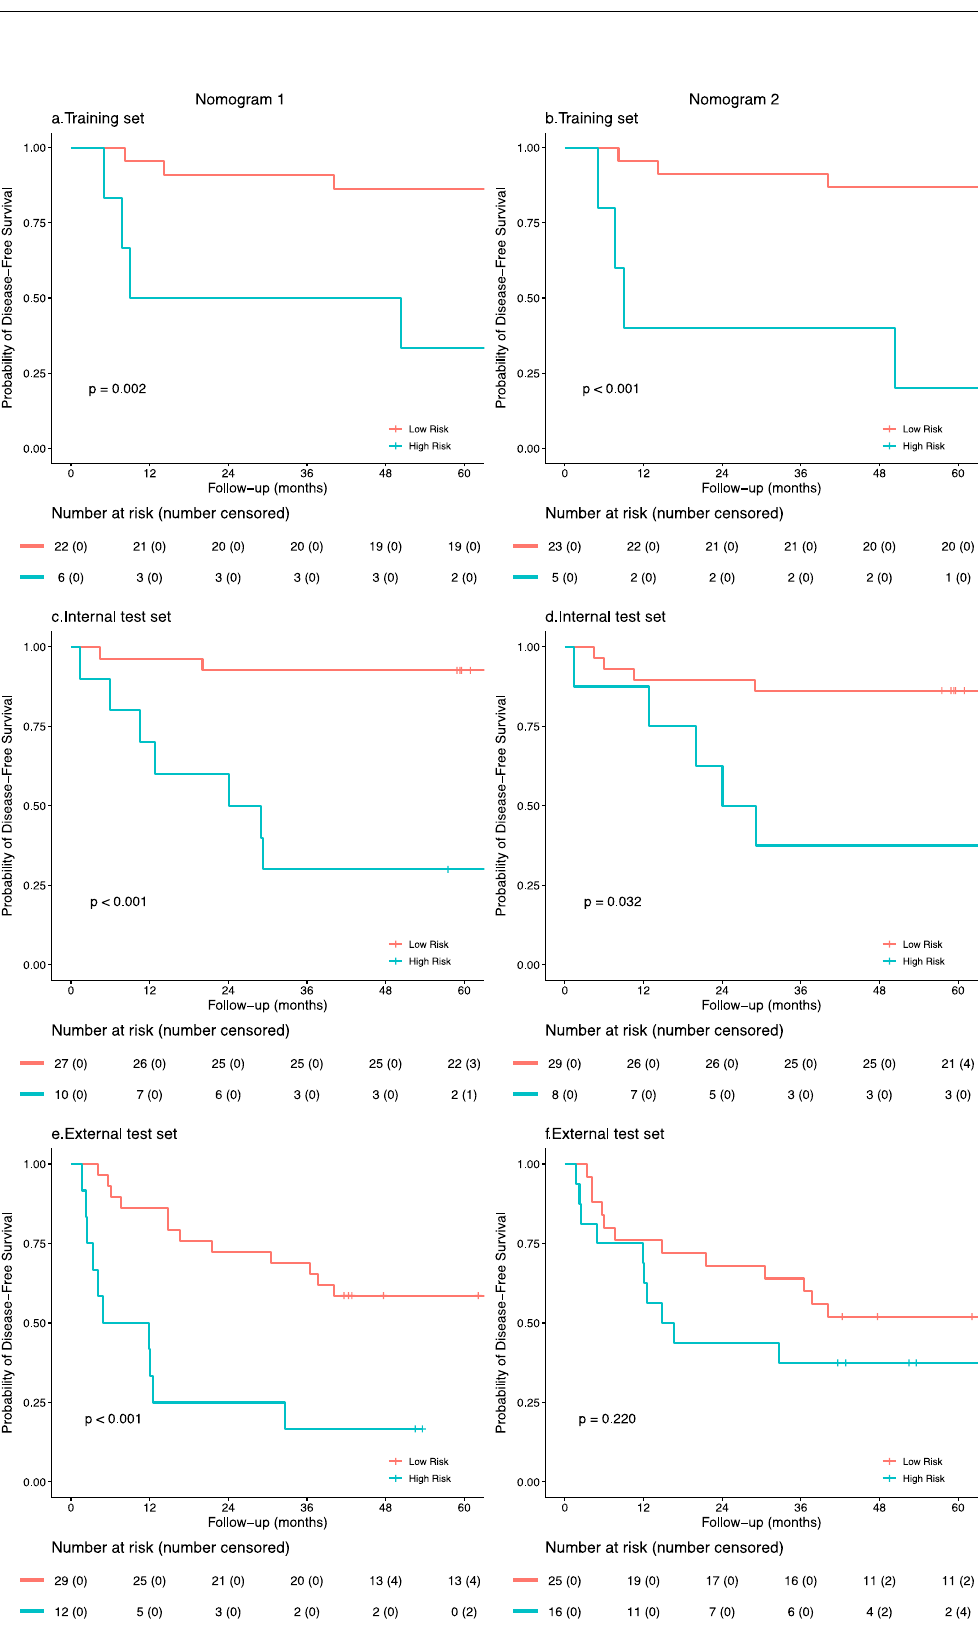
Figure 5. Disease-free survival for patients from high-risk (blue) and low-risk (pink) groups stratified by nomogram predictions. ( a , c , e ) Nomogram 1 with genomics feature selection. ( b , d , f ) Nomogram 2 without genomics feature selection. Kaplan–Meier curves showing disease-free survival in patients stratified by nomogram predictions in the training, internal test and external test set. Risk tables under Kaplan–Meier curves showing the number of patients at risk at 0, 12, 24, 36, 48, and 60 months. The difference between the two curves was compared by the log-rank